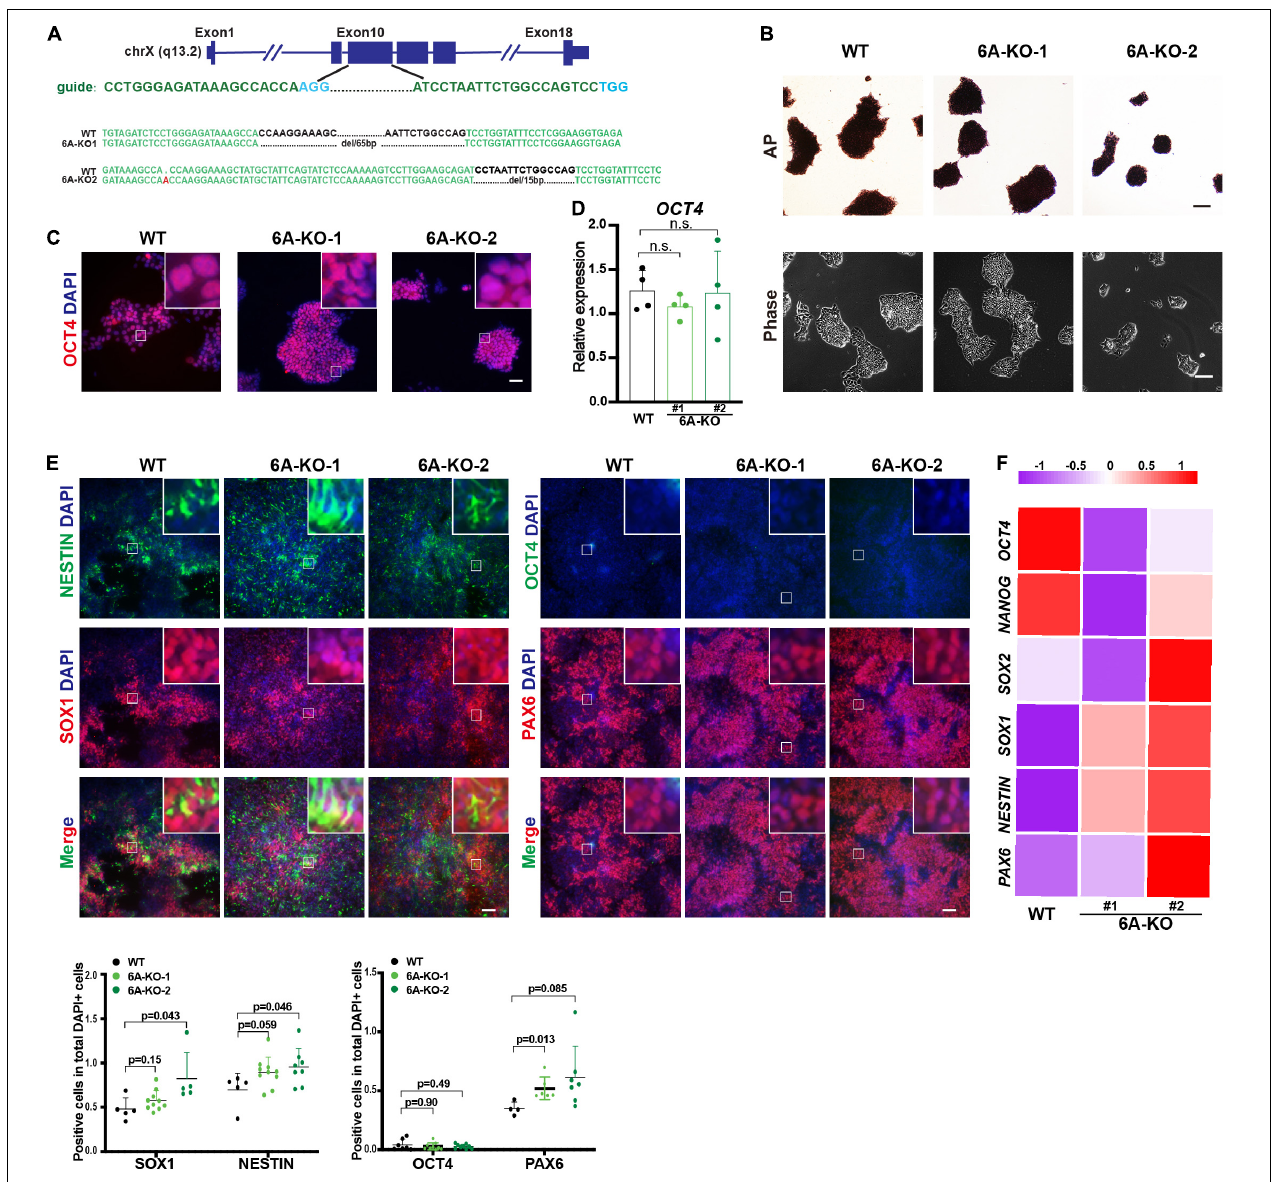
FIGURE 3 | KDM6A knockout improved the neuroectoderm differentiation. (A) Illustration of KDM6A locus, sgRNA sequences, and generated mutations. (B) Morphology and AP staining of KDM6A-KO cells and wild-type ESCs. Scale bar = 100 µ m. (C,D) The RT-qPCR analysis (C) and immunofluorescence staining (D) of the pluripotent marker in the KDM6A-KO cells at undifferentiated ESC states. Scale bar = 50 µ m. (E,F) The immunofluorescence staining images (up) and quantification (down) (E) and RNA analysis (F) of pluripotent or neural markers in the KDM6A-KO cells after 7 days of neuroectoderm differentiation ( n ≥ 3; mean ± SEM is plotted). Scale bar = 50 µ